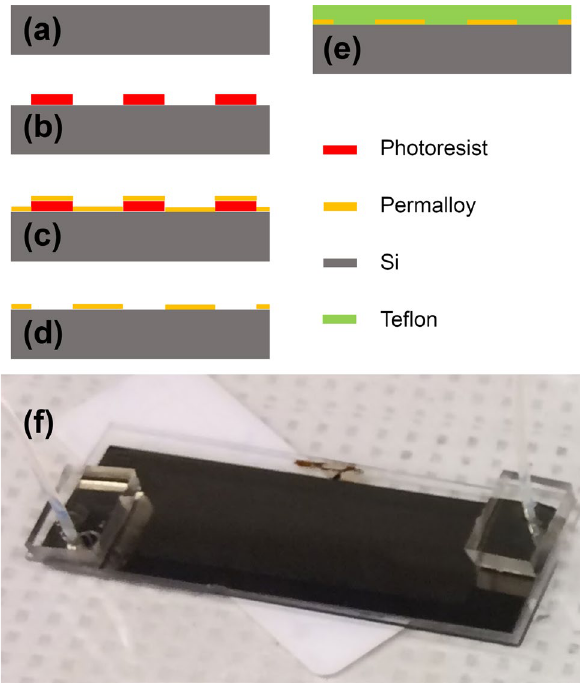
Figure 9. Microchip fabrication protocol. ( a ) Starting from a silicon wafer, (b) photoresist is patterned, ( c ) the chip is covered by permalloy, (d) liftoff removes the excess material, and ( e ) the chip is covered by a non-fouling layer (e.g., Teflon). ( f ) A sample complete microfluidic chip is